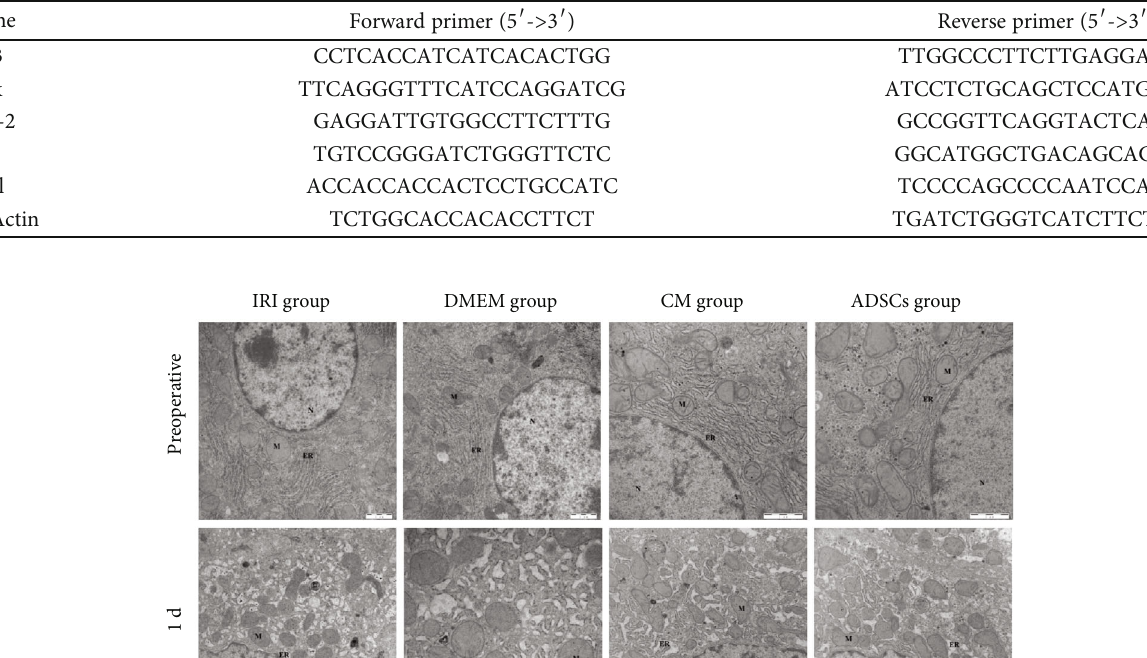
Table 1: Sequences of primers used in real-time PCR.